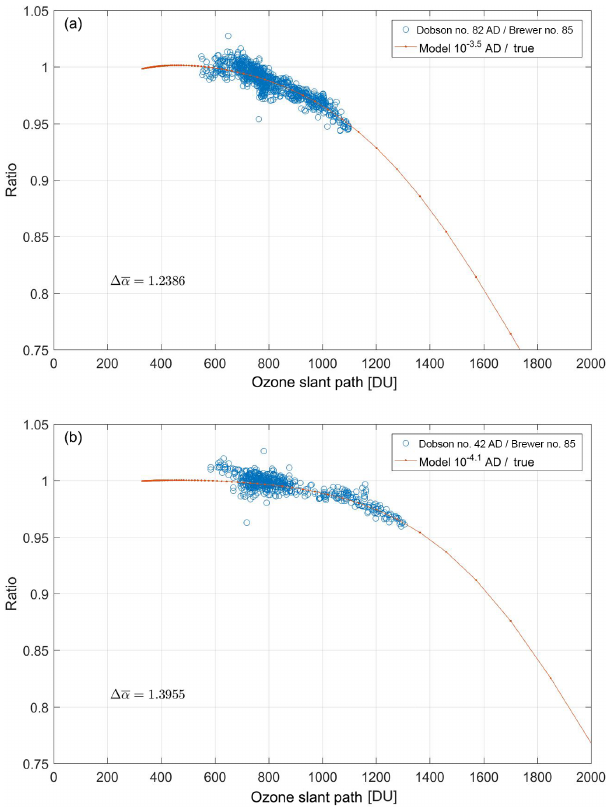
Figure 10. The ratio of quasi-simultaneous observations of (a) Dob- son no. 82 and (b) no. 42 AD wavelengths to double Brewer no. 085 data at the South Pole for total ozone values larger than 220DU as well as the ratio of the values retrieved from the physical model de- veloped in this study with certain amounts of stray light to the true value assumed in the atmosphere suggesting the level of stray light in each individual Dobson instrument. The ETC values and ozone absorption coefficients are calculated for each model separately us- ing the Langley method. Note that the average difference between the Brewer and Dobson data with OSPs less than 800DU was used to scale the Dobson data first. Then the model with a stray light level that better matches the Dobson data was found. The scaling factors used for Dobson no. 82 and no. 42 are 1.02 and 1.0076,